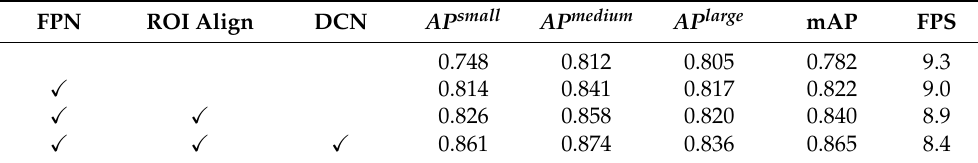
Table 3. Ablation